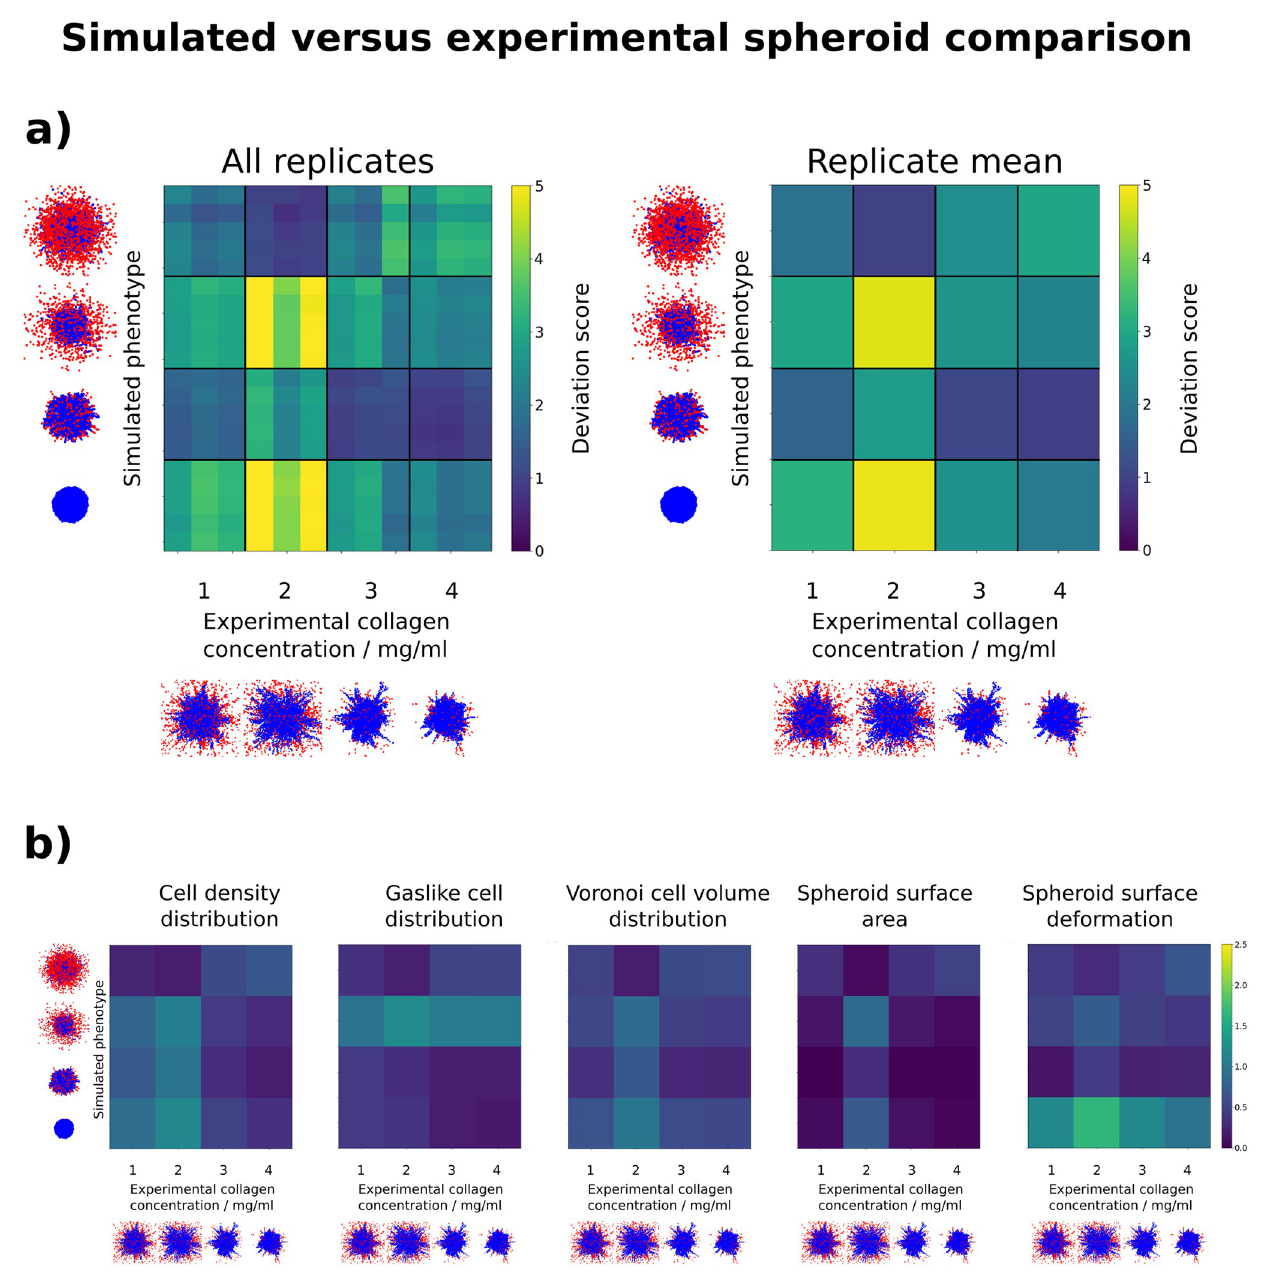
Fig 8. Deviation score comparison between in vitro spheroids grown in media at four different collagen concentrations c (data provided by Kang et al [13]), and in silico spheroids exhibiting four different phenotypes, simulated by us. a) Shown are the deviation scores between three replicates of each collagen concentration, grown for three days, and five replicates of each simulated phenotype, simulated for 250 000 MC steps. A single MC step corresponds to roughly 1 s of real time in this context. Each individual deviation score is shown on the left, and the average within a pairing of collagen concentration and phenotype is shown on the right. A top-down view of the spheroid point cloud of a representative replicate for each collagen concentration / phenotype is shown next to both heatmaps. Blue cells are classified as non-gaslike, and red cells are classified as gaslike. See S2 Fig for an enlarged view of all experimental spheroid point clouds, and Fig 6 for an enlarged view of all simulated spheroid point clouds. We observe the highest average deviation scores between c = 2 mg/ml and the “spherical” phenotype. The lowest average deviation score is found between c = 4 mg/ml and the “deformed” phenotype b) Individual metric distances for each of the features constituting the overall deviation score. Shown are the standardized and weighted metric distances between three replicates of each collagen concentration, grown for three days, and five replicates of each simulated phenotype, simulated for 250 000 MC steps. A single MC step corresponds to roughly 1 s of real time in this context. Due to the overall deviation score being a sum of all weighted feature distances, the color range has been adjusted here. The highest deviation score observed in a) is a combination of high metric distances in all features, especially the spheroid surface deformation. On the other hand, the lowest deviation score observed in a) stems from overall low values, especially in the spheroid surface area.